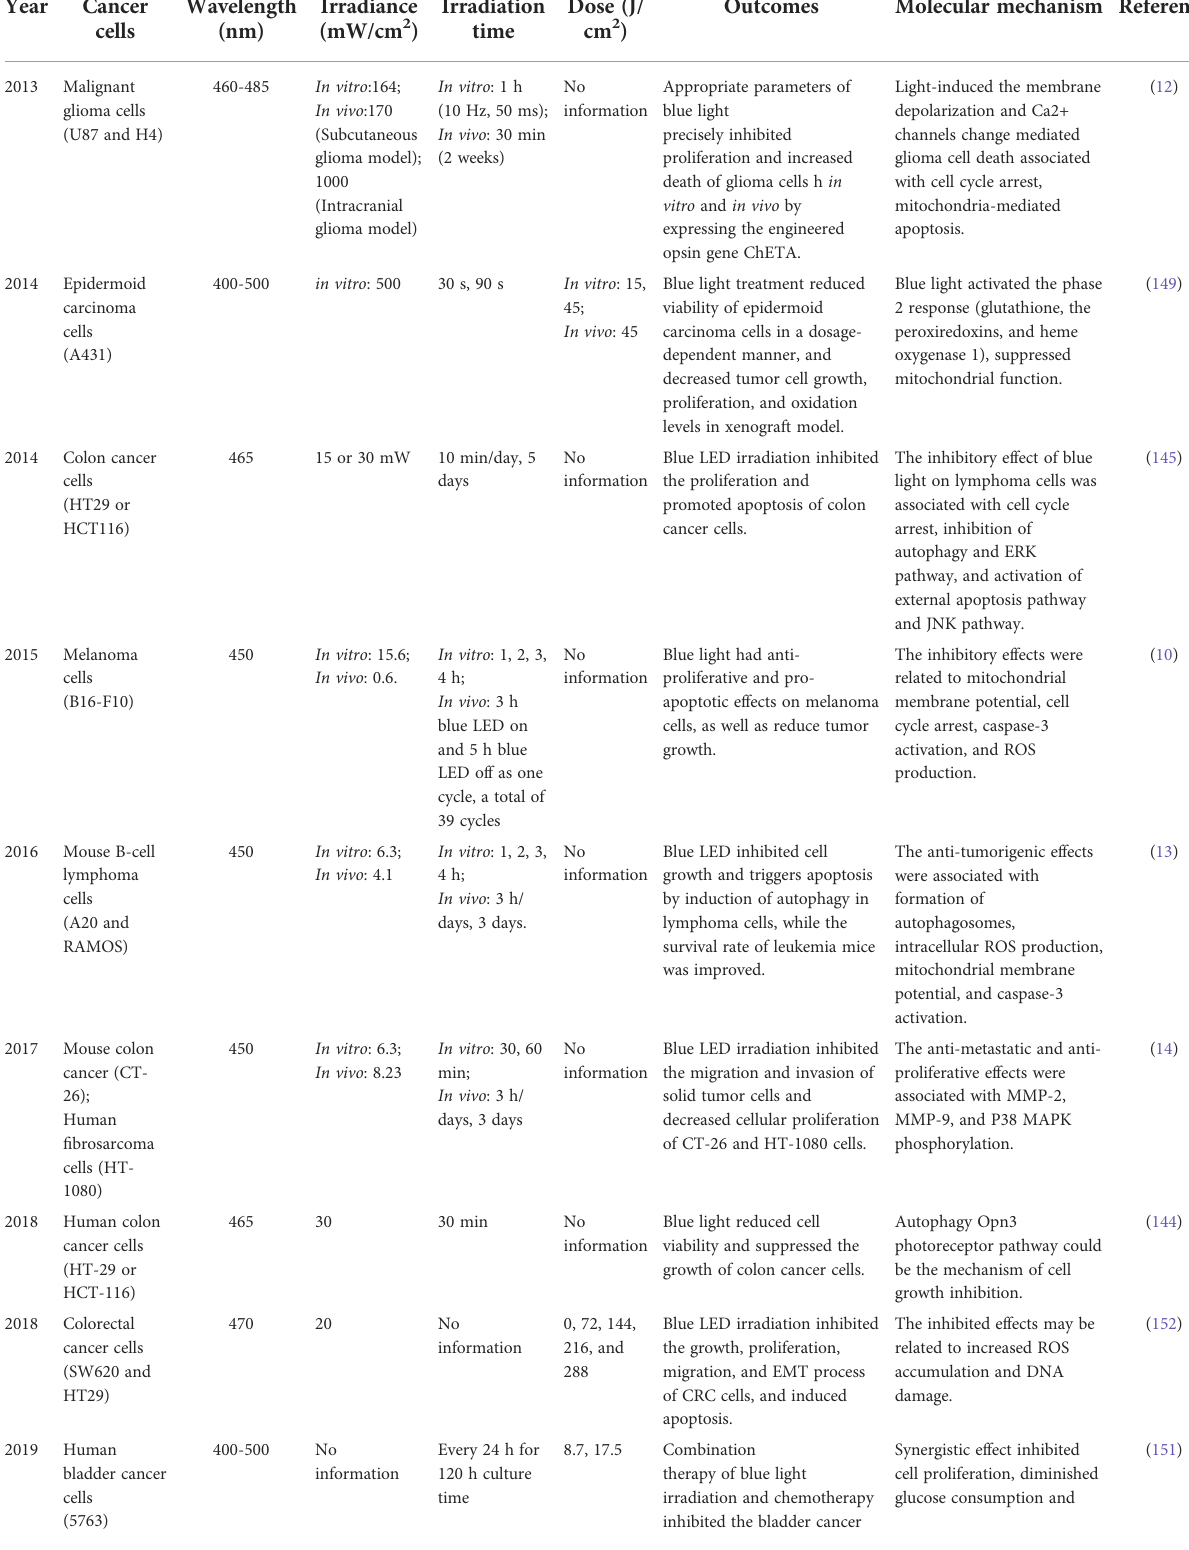
TABLE 1 Summary of the most relevant experimental studies on cancers treatment by blue light